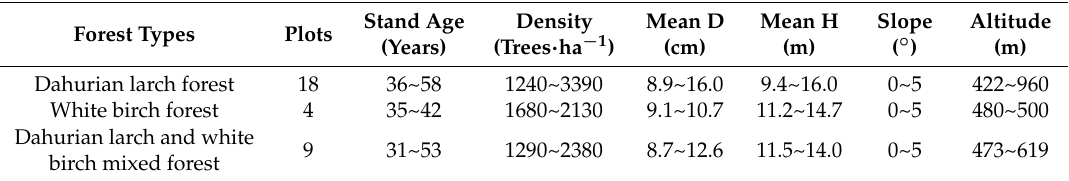
Table 1. Characteristics of forest types from which the sample trees were selected. D = tree diameter at breast height; H = tree height.